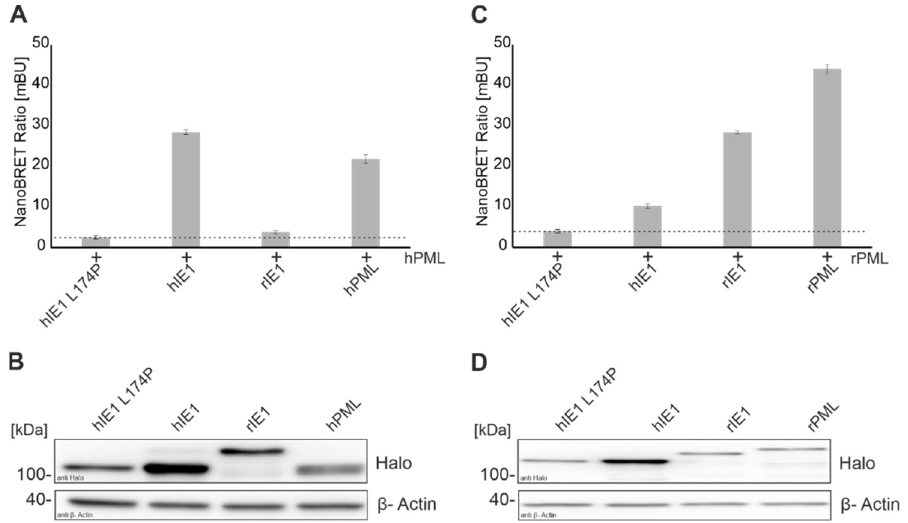
Figure 1. Establishment of a NanoBRET assay for quantitative assessment of IE1-PML interactions. ( A , C ) Interaction analysis of IE1 homologs with human PML ( A ) and rat PML ( C ) was performed by transfection of HEK293T cells with Halo tagged IE1 homologs, and Luc tagged PML (Ratios: Halo-IE1: Luc-hPML 1:10; Halo-IE1: Luc-rPML 1:100) for 24 h. After 4 h of incubation with the Halo ligand, emission signals were measured by adding the NanoBRET substrate at wavelengths of 618 nm and 448 nm for 5 s with the Hidex Chameleon. Interactions of IE1 homologs with PML of different species are represented by the mean values ± standard deviation (SD) from three independent experiments with three replicates each. ( B , D ) Expression of Halo-tagged proteins was detected in Western blot analyses with a Halo tag antibody and actin as a loading control.